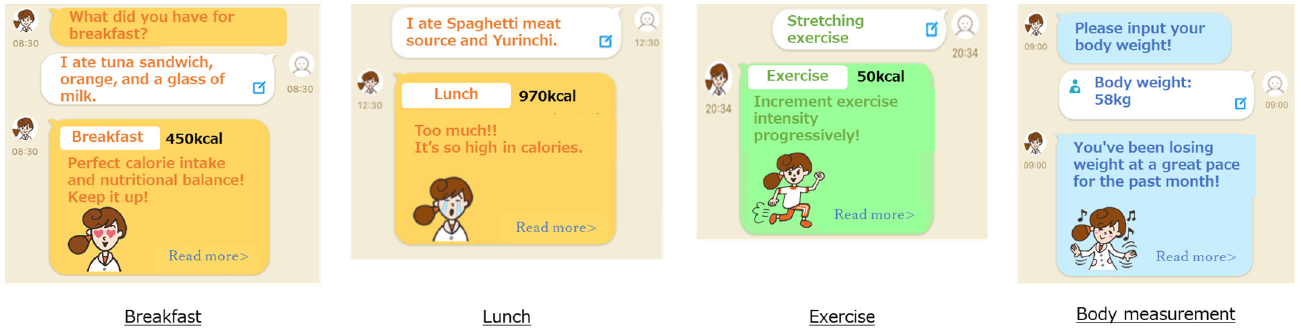
Figure 1. Screenshots of CALO mama